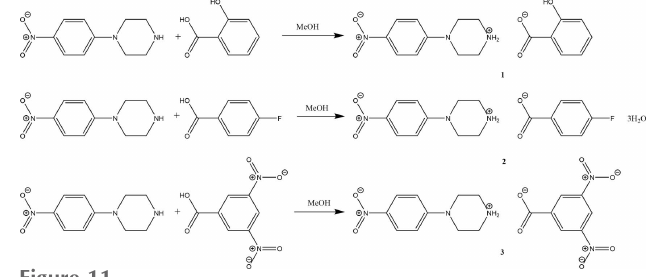
Figure 11 Reaction scheme for the synthesis of 1 , 2 and 3 .